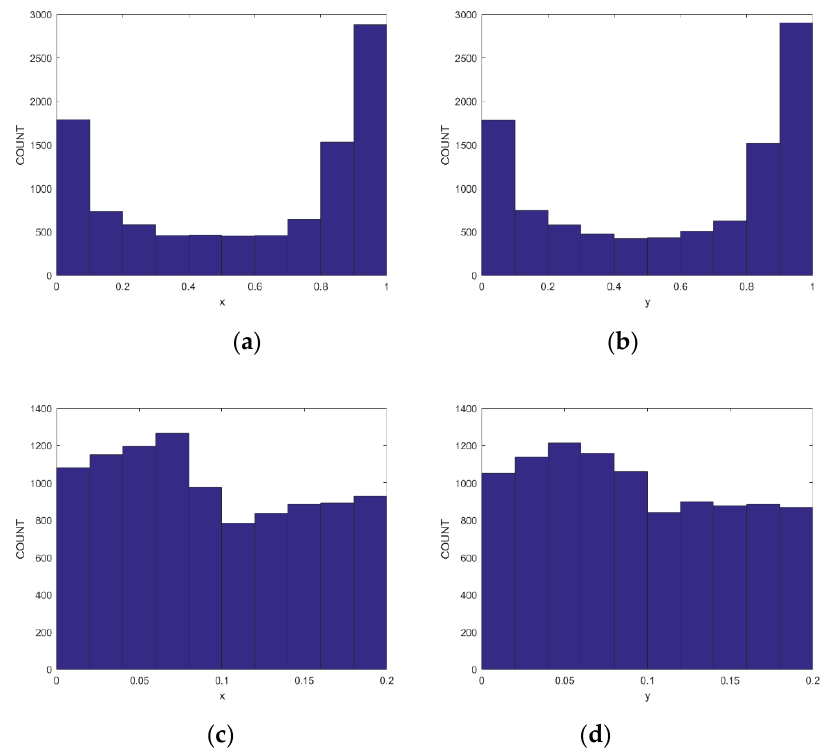
Figure 2. Sequence statistical histograms of 2D-LASM and 2D-ILASM: ( a ) Component x of 2D-LASM; ( b ) Component y of 2D-LASM; ( c ) Component x of 2D-ILASM; ( d ) Component y of 2D-ILASM.